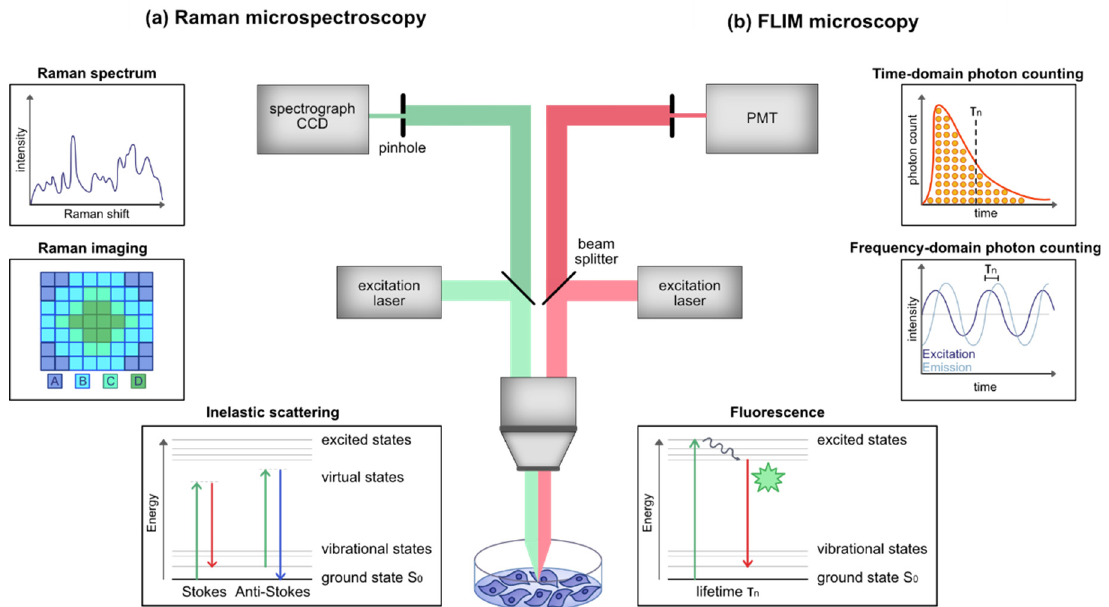
Figure 1. Schematic of Raman and FLIM instrumentation. The basic light pathway of both techniques is initiated at a laser source which is directed on the sample to induce photon–matter interactions. The emitted or scattered light is then directed through a beam splitter and a pinhole to the detector. ( a ) In Raman microspectroscopy, inelastic scattering results in energy transfer processes to higher (anti-Stokes) or lower (Stokes) energy levels than the excitation source. Raman spectroscopy requires a spectrograph e.g., with a charge-couple device (CCD) camera as a detector and Raman spectra are the typical readouts. By raster scanning, hyperspectral Raman images can be generated, where each pixel corresponds to one specific Raman spectrum. ( b ) Fluorescence lifetime decays are the targeted processes in fluorescence lifetime imaging (FLIM) microscopy. The average time that a fluorophore spends in the excited state can be detected by photomultiplier-tubes (PMT). The most common acquisition modes are frequency-domain or time-domain photon counting.